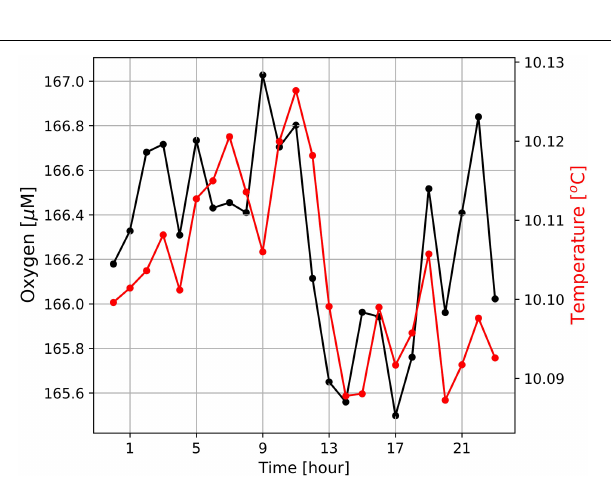
FIGURE 6 | Diurnal cycles of dissolved oxygen and sea water temperatures at the mooring site ( Figure 1 ) averaged over the entire period of observation from February 19th 2019 to October 13th 2020. Mean standard deviations of ± 24.5 µ M (oxygen) and ± 0.45 ◦ C (temperature) are large and not shown as this would have masked the general